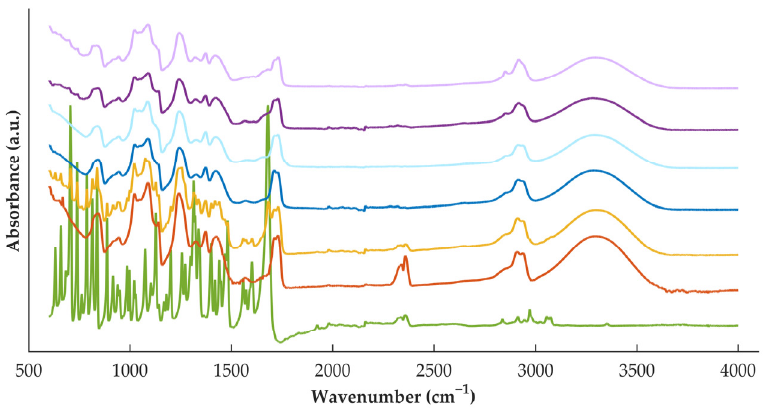
Figure 3. FTIR spectra of DZP (green) and PVA (orange) raw materials, physical mixture (yellow) and placebo filaments (dark blue) or tablets (light blue), and DZP-loaded filaments (dark purple) or tablets (light